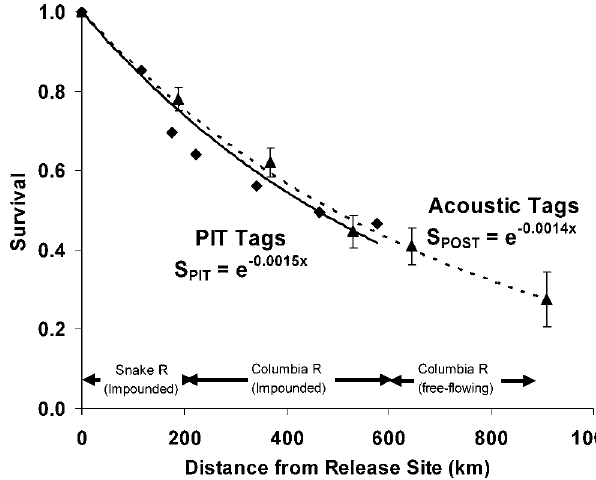
Figure 2. Comparison of 2006 Dworshak (Snake River) Spring Chinook Smolt Survival Estimates Using Acoustic Tags Measured with the POST Array with Published Data Using PIT tags Accoustic array data are shown as means 6 1 standard error (SE). The PIT tag data are from Tables 19 and 41 of [21]. The last two PIT tag data points are an aggregate of all Snake River spring Chinook tagged in the Snake River Basin. Regression estimates of the decline in survival with distance are statistically indistinguishable for Dworshak Hatchery smolts tagged with either PIT tags (diamonds) or acoustic tags (triangles) ( p . 0.05), and are consistent with a single constant mortality rate above and below the hydropower system.